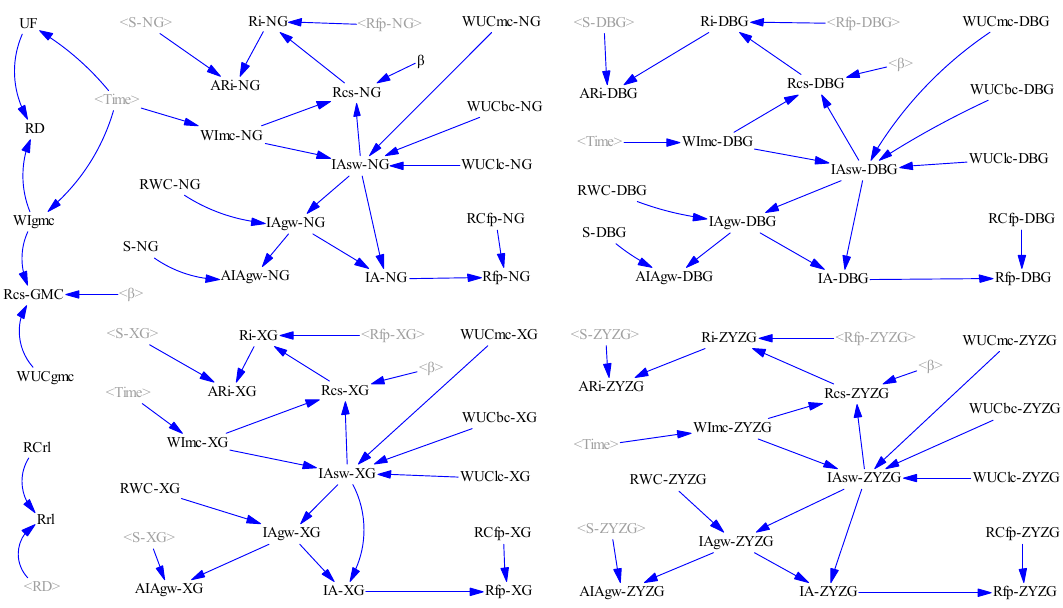
Figure 4. Structure diagram of irrigation and surface water subsystems in the Changma Irrigation District.